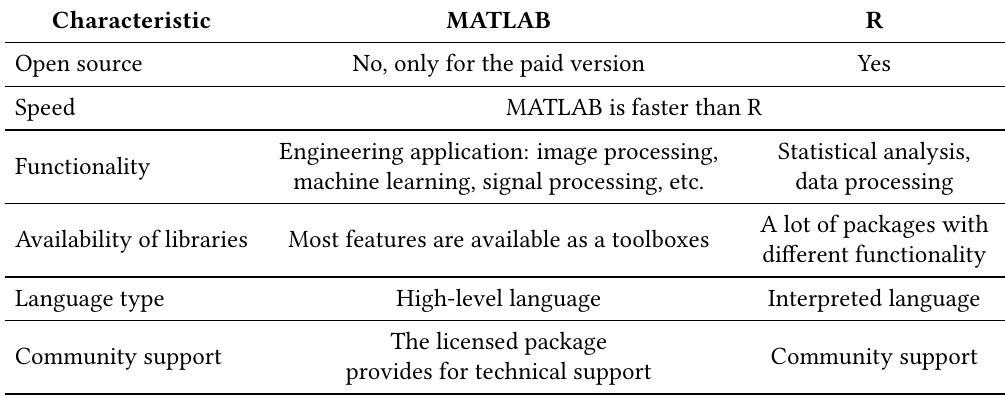
Table 2 Comparative analysis of MATLAB and R (source: